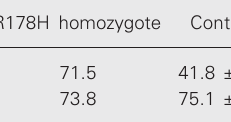
Table 1. Activation energies of the isoenzymes of plasma Hex isolated by chromatography in a DEAE-cellulose column using 3,3'-dichorophenol- sulfonphtaleinyl N-acetyl-ß-D-glucosaminide as substrate.